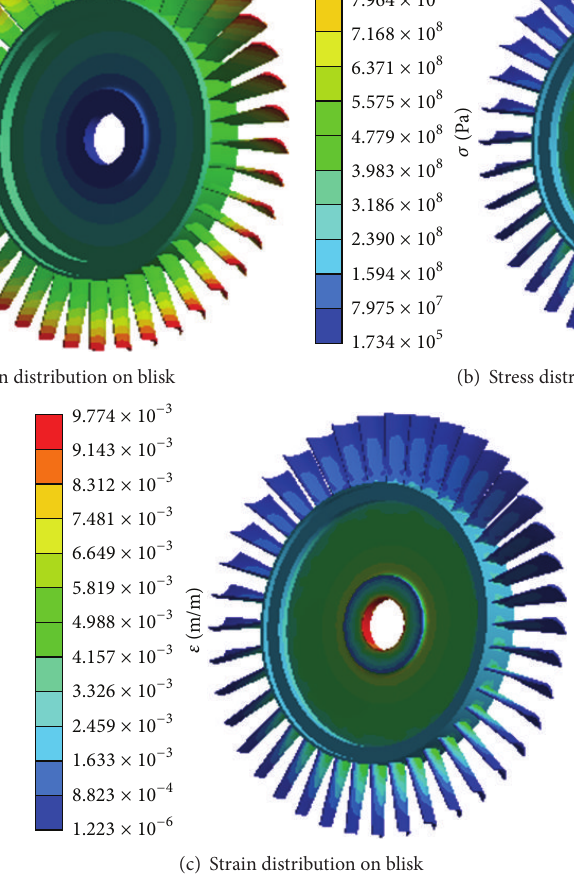
Figure 7: Deformation, stress, and strain distribution on blisk.